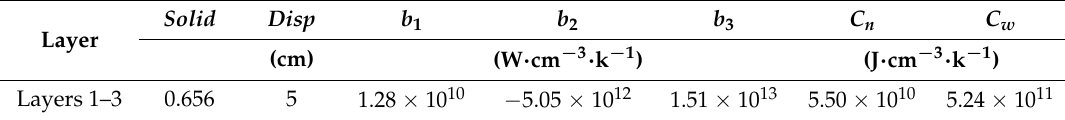
Table 3. Heat parameters obtained by the model after